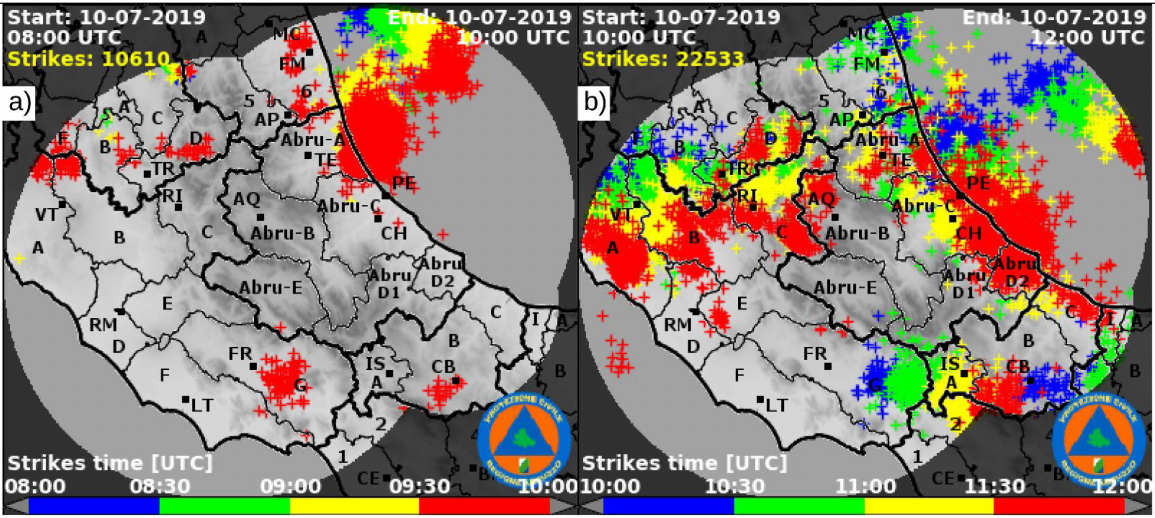
Figure 3. Lightning strokes on 10 July 2019: ( a ) lightning strokes between 08:00 and 10:00 UTC, ( b ) strokes between 10:00 and 12:00 UTC. Images are built from blitzortung network data (https://www.blitzortung. org accessed on 20 January 2022) . In the map the codes RM, AQ, and PE correspond to Rome, L’Aquila, and Pescara,